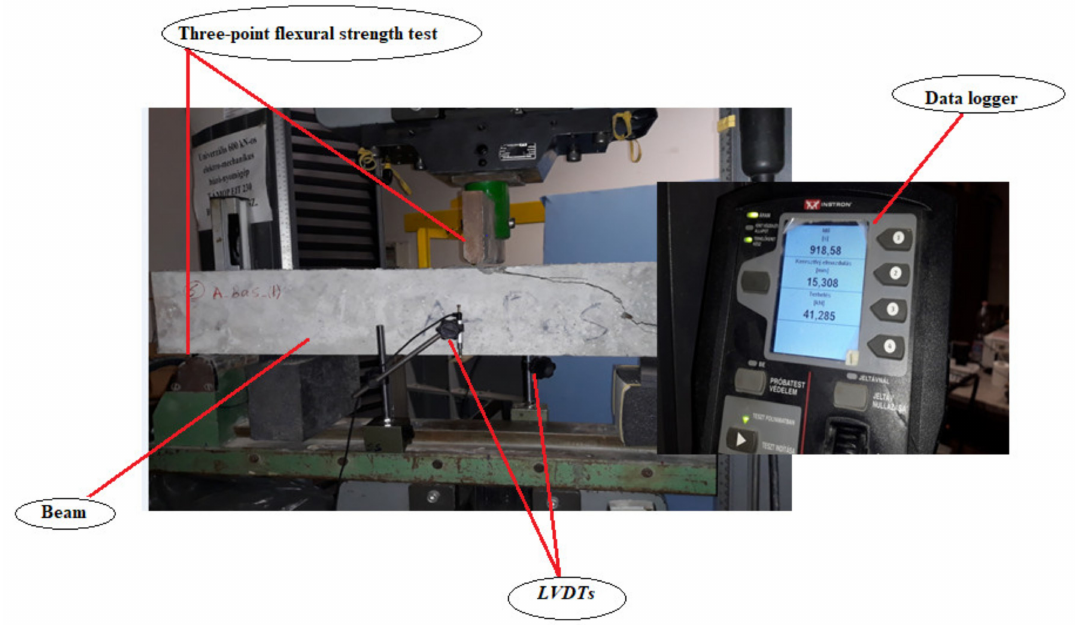
Figure 5. Three-point bending strength test and data